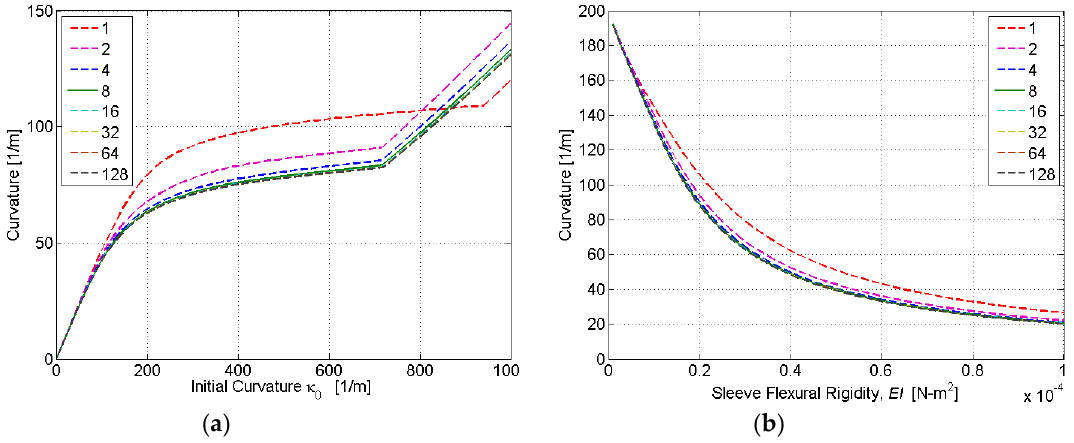
Figure 7. Dependence of the simulated actuator curvature on discretization number (N): ( a ) as a function of the initial tendon curvature κ 0 , ( b ) as a function of the sleeve flexural rigidity EI.